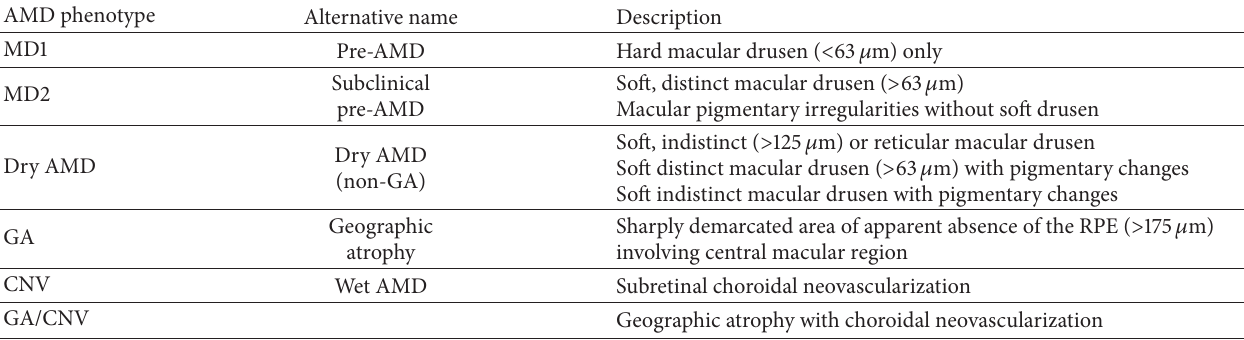
Table 1: Description of AMD phenotypic subtypes according to Newman et al. [1]. Abbreviated names in the first column are used in labeling the cladograms’ legends in Figures 1 and 2.